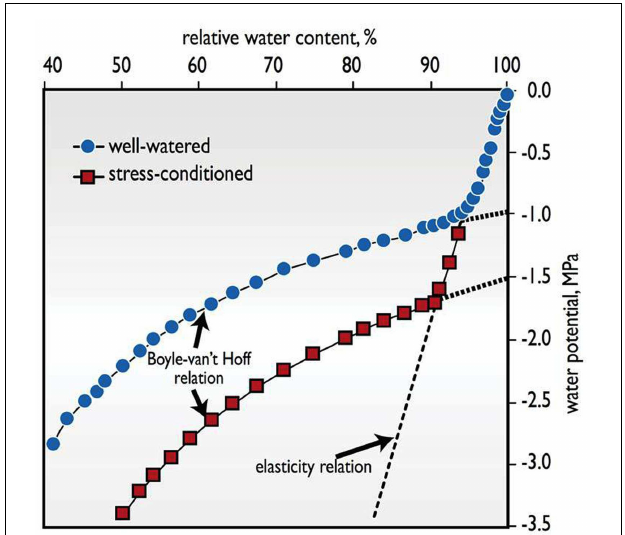
FIGURE 1 |The advantages of accumulating osmotically active solutes is illustrated with the response of total water potential ( Ψ w ) to a lowering of relative water content (RWC) in wheat leaves, comparing a plant that was well-watered with another that was stress-conditioned by several cycles of water deficit and rewatering over a number of weeks, causing it to accumulate additional osmotically active solutes (Adapted from Melkonian et al., 1982). Two phases are identified. In tissue equilibrated with free water ( Ψ w ≈ 0MPa), a large positive turgor pressure balances the osmotic component of water potential. As water is lost, turgor decreases steeply, reflecting the rather stiff cell walls in mature organs, in accordance with the elasticity relation. At RWCs below the point of zero turgor (the inflection point), the relationship is dictated by the less steep Boyle-van’t Hoff relation between osmotic solute activity and water potential, Ψ w ≈− RTC , where R is the ideal gas constant, T is the absolute temperature, and C is the concentration in moles of osmotically active solutes per kg of water.Tissues that accumulate more solutes via the process of osmotic adjustment, such as the stress-conditioned leaf shown here, shift the Boyle-van’t Hoff curve to lower water potentials. As a consequence, the tissue can maintain positive turgor over a wider Ψ w range and incur less shrinkage at still lower levels of Ψ w below the turgor loss point. Such shrinkage and low Ψ w can damage the integrity of cell membranes and other cell constituents, and lead to cell death as in stress-induced leaf